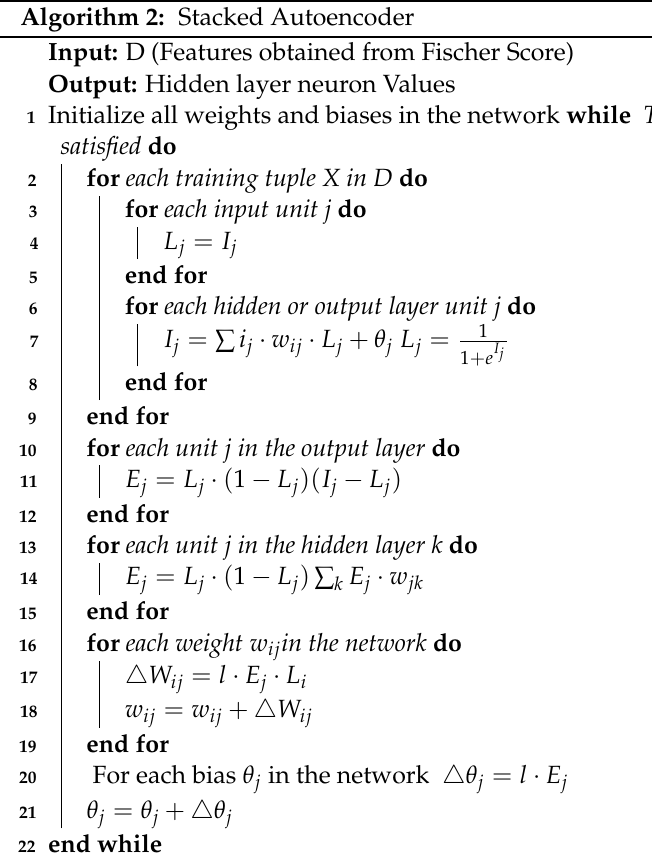
Algorithm 2: Stacked